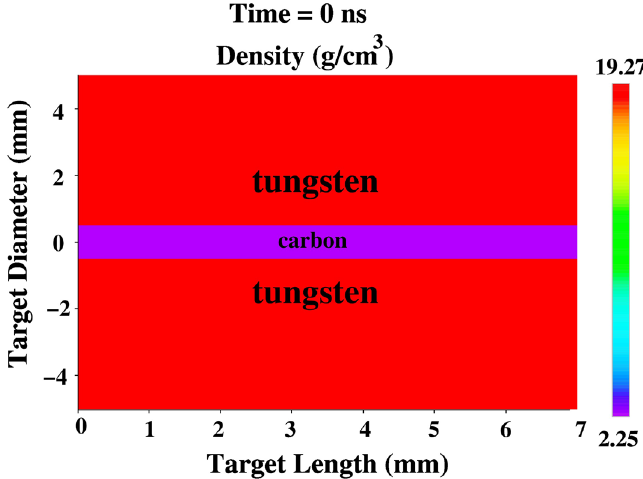
Figure 6. Initial target density distribution generated by BIG2 code.